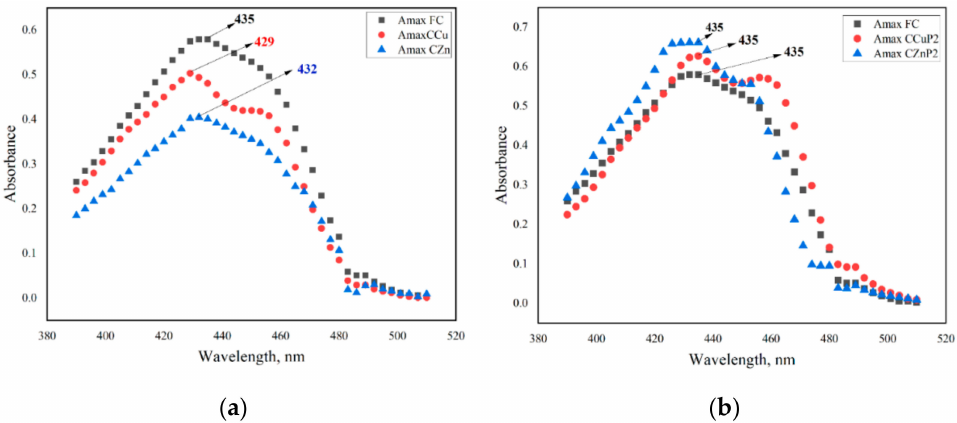
Figure 5. Ultraviolet (UV) spectra for FC, FC complexes with Cu 2+ and Zn 2+ ions ( a ) and for curcumin extracted from the P2C sample, which was previously immersed for 4 h in copper and zinc sulfate solutions ( b